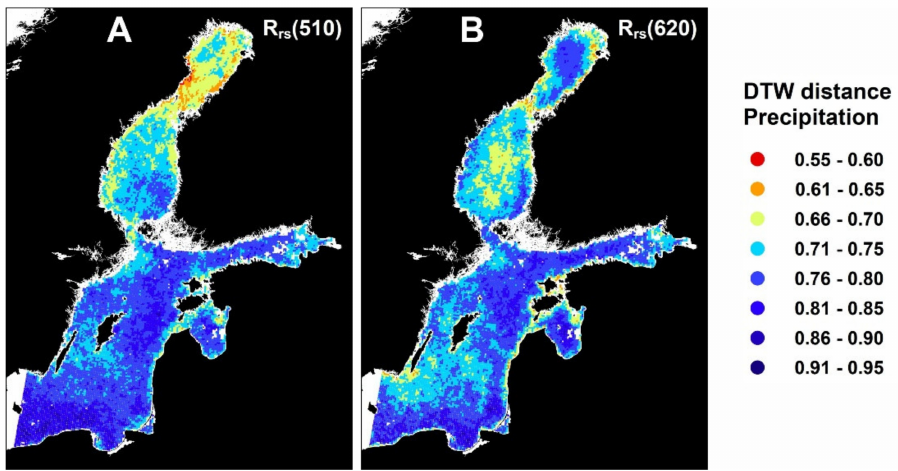
Figure 13. Time series distances from (standardized) precipitation with 50 km radius to R z ( λ ). In reddish areas precipitation was more closely followed by elevated reflectance than in blueish areas. ( A ) north wind, ( B ) east